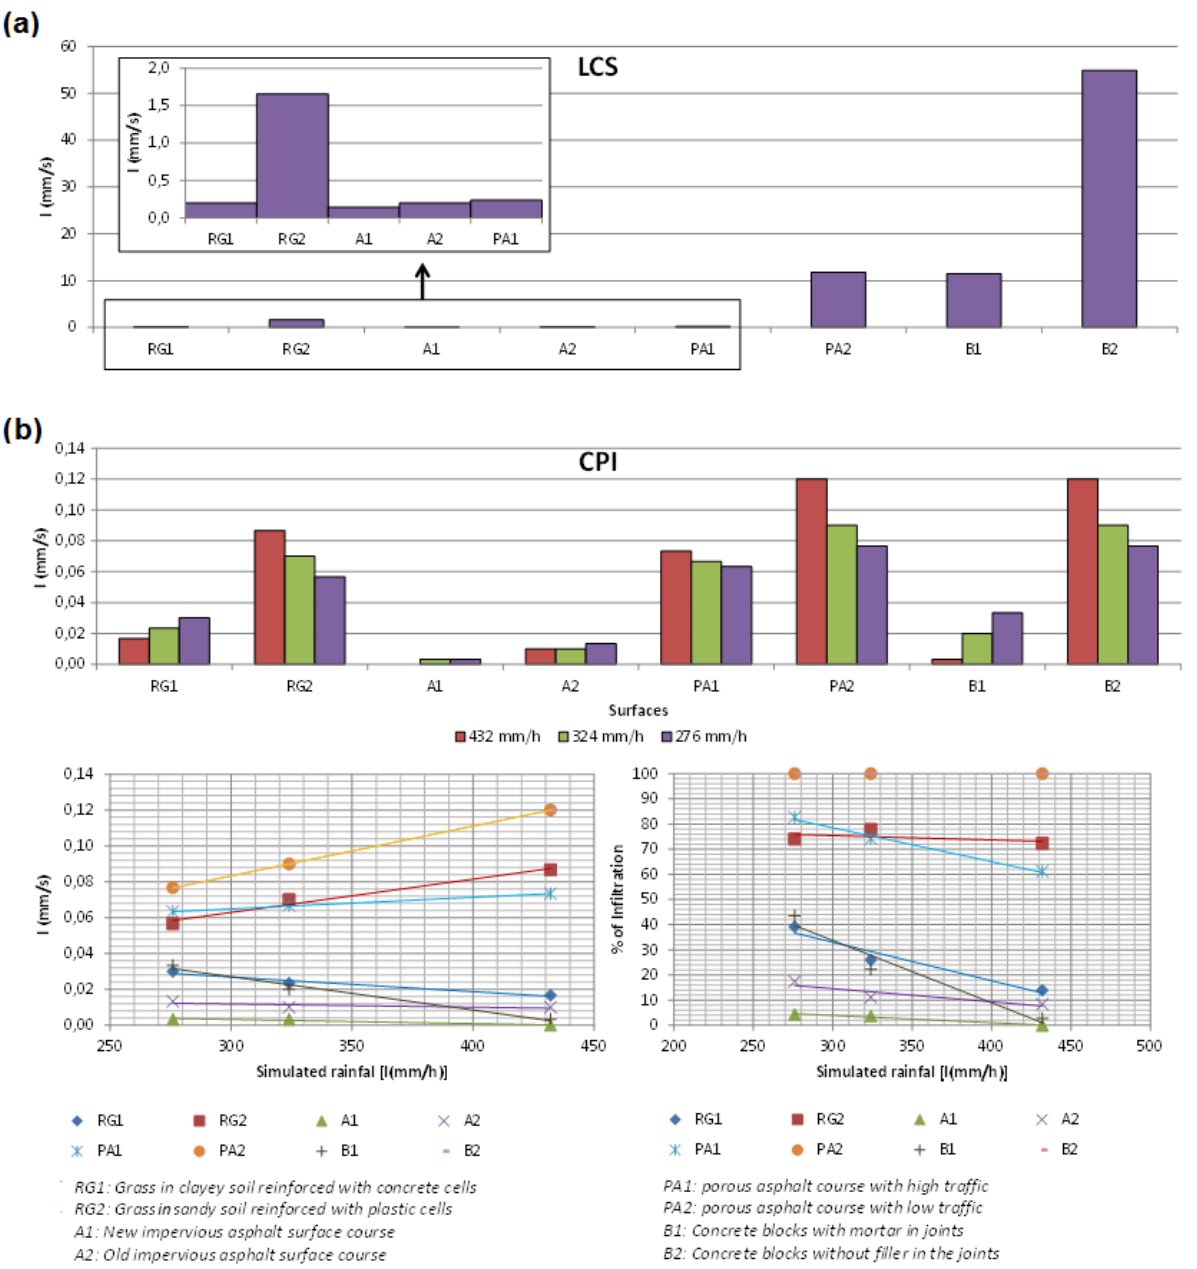
Figure 6. Permeability results obtained with CPI and LCS for different surfaces (self-made, obtained from results obtained by Fernandez-Barrera et al. [46]. ( a ) LCS obtained results and ( b ) CPI obtained